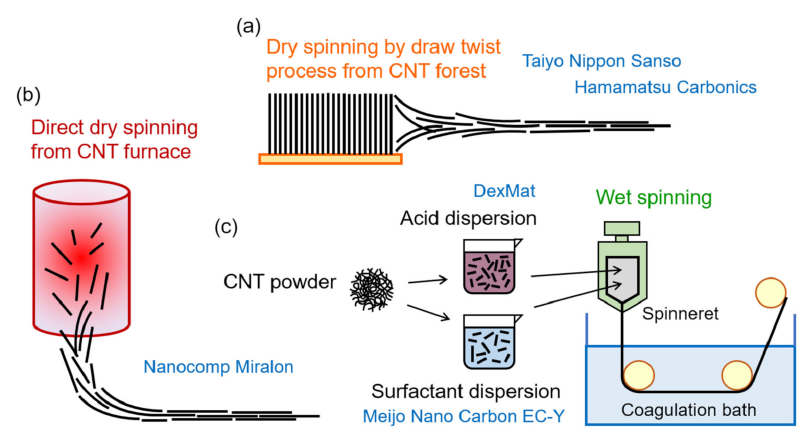
Scheme 1. Schematic representation of spinning methods for CNTs. ( a ) Dry spinning by draw